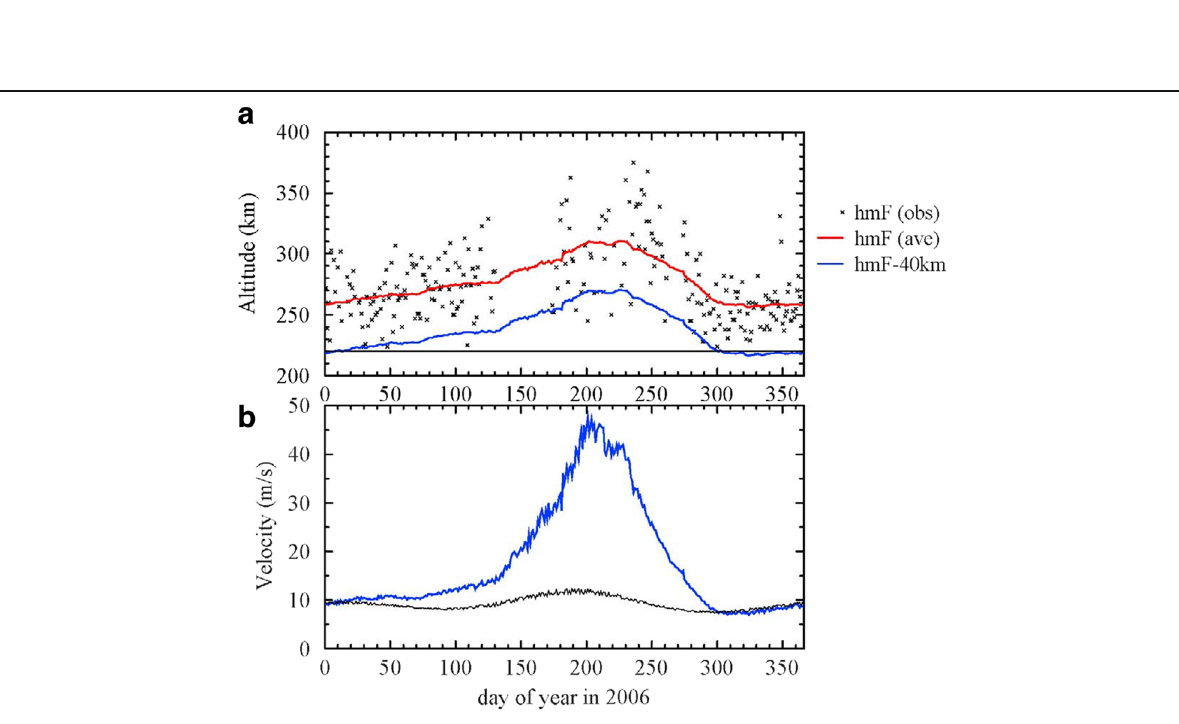
Fig. 11 ( a ) Seasonal variation of ionospheric altitude; crosses represent hmF2 derived from foF2 and M(3000)F2 at Chumphon, Thailand. The running average of the daily hmF2 with a window of 3 months is shown by the red curve. The blue curve shows the altitude of the bottom-side ionosphere, which is defined as the altitude 40 km lower than the averagedhmF2 (red curve). ( b ) Estimated g × B drift velocity; the blue curve shows the g × B drift at the bottom side of the ionosphere as defined in the top panel. The black curve shows the g × B drift at a fixed altitude of 220 km (after Nishioka et al.